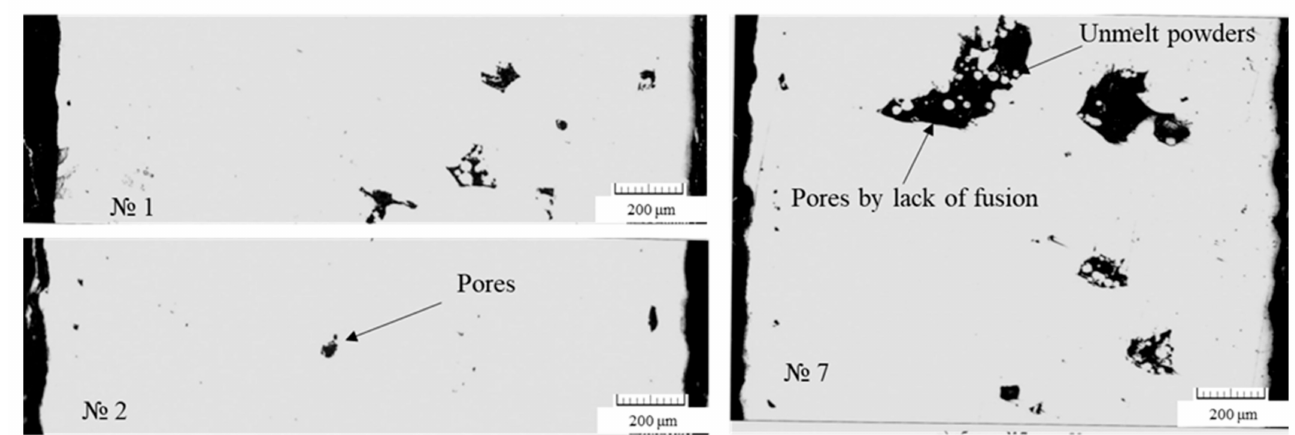
Figure 4. Defects in samples.